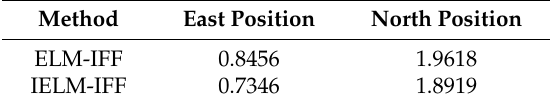
Table 10. Position (m) RMSE for different algorithms in the case of good GPS signal.